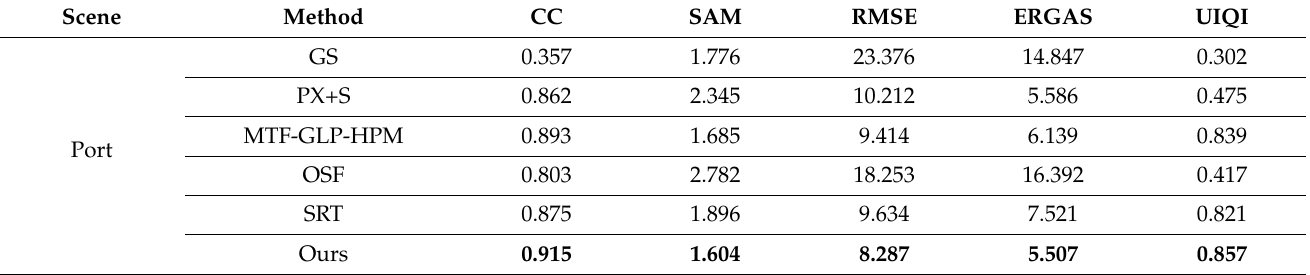
Figure 4. Comparison of fusion results of different algorithms on simulation data (the original image was taken in Beijing on 3 May 2022; scene: airport). Table 2. Objective evaluation indexes of the method in this paper and several advanced fusion